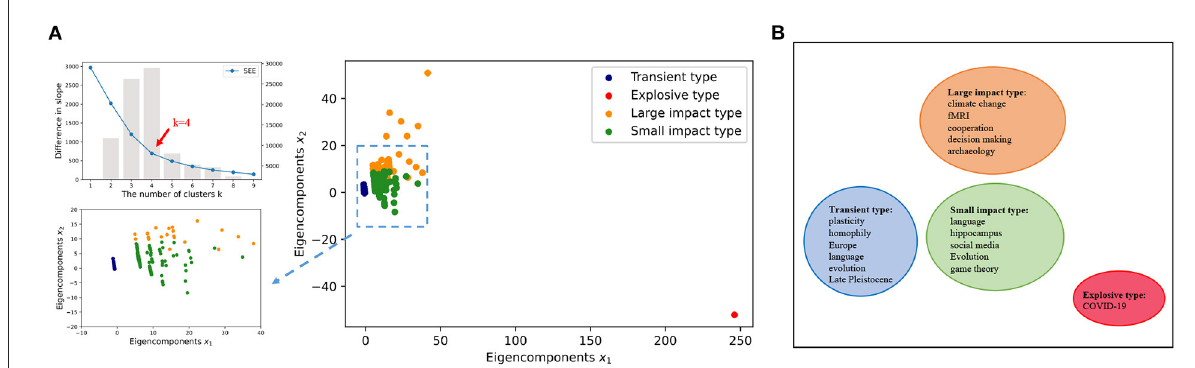
4. We use k-means clustering =